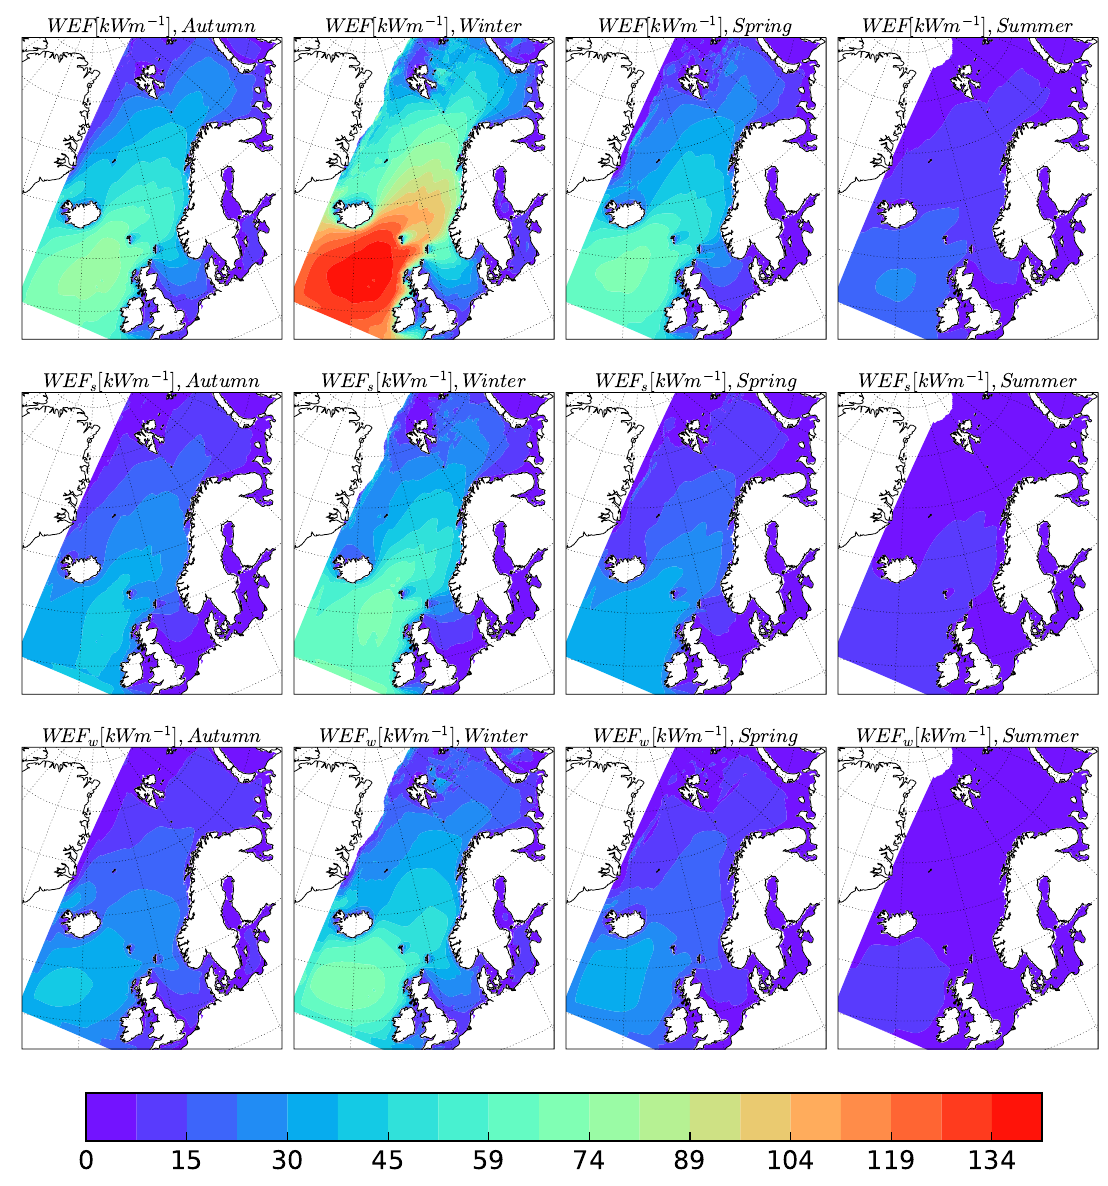
Figure 5. The average seasonal (autumn, winter, spring, and summer) WEF , WEF s , and WEF w for the NORA10 domain for the period